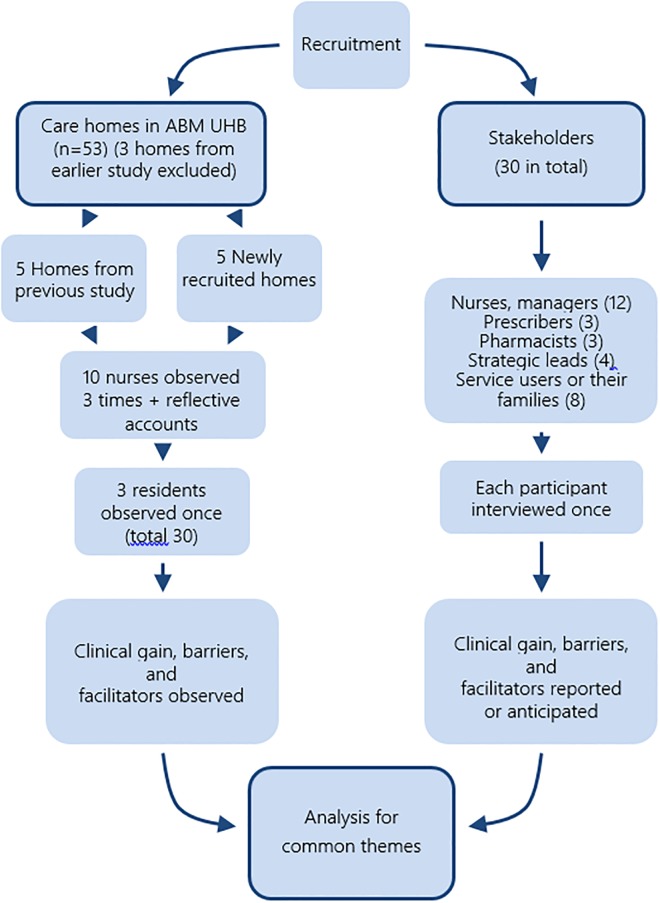
Participant flow diagram.